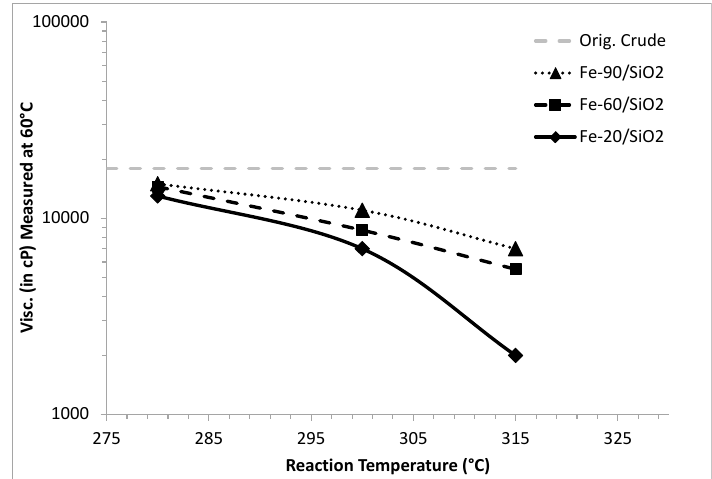
Figure 1. Viscosity (cP) at 60 °C of the upgraded crude oil using iron-containing catalysts.